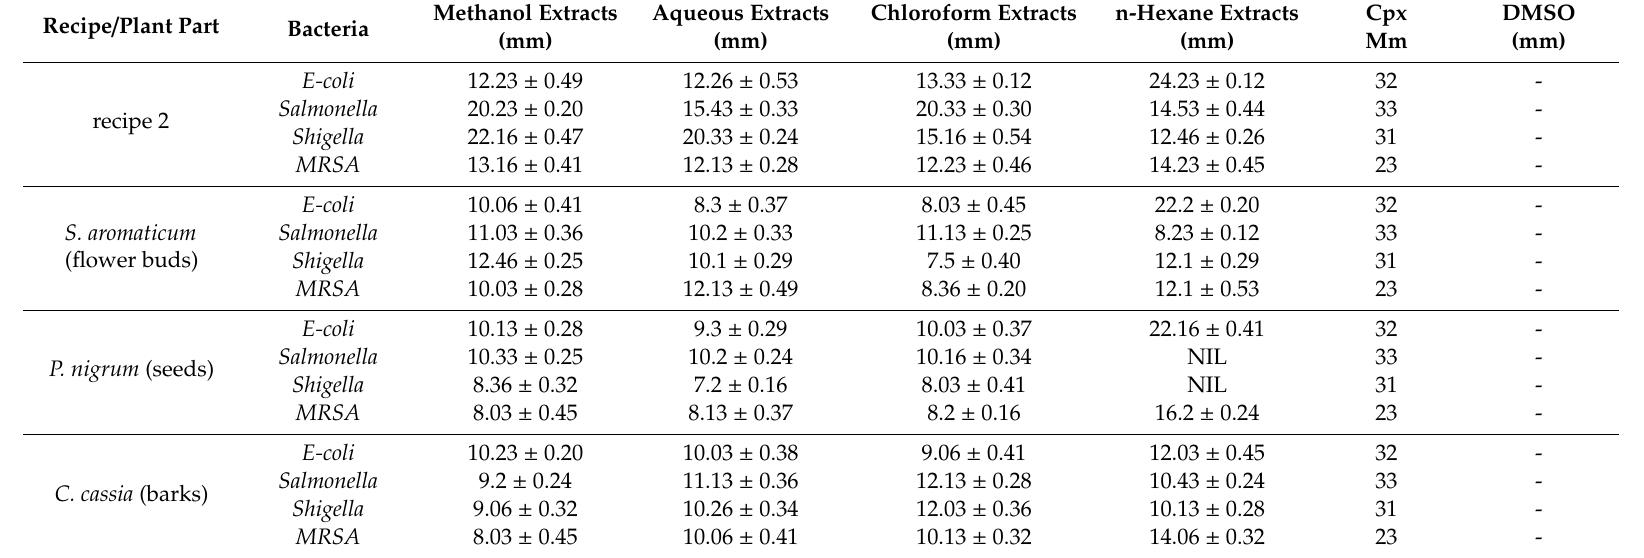
Table 5. Comparative Antibacterial evaluation of methanol, aqueous, chloroform and n-hexane extracts of the S. aromaticum, P. nigrum, C. cassia and recipe